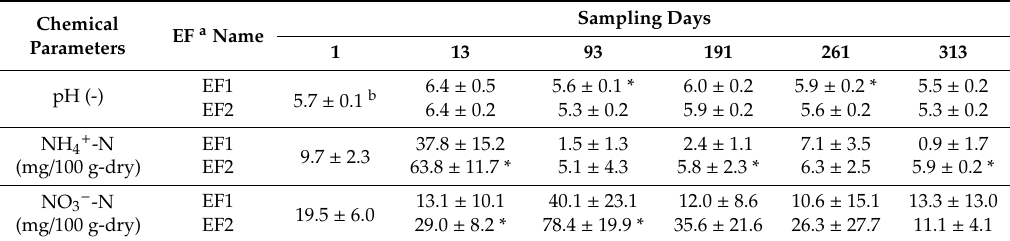
Table 2. Chemical parameters of pH, ammonia, and nitrate at experimental